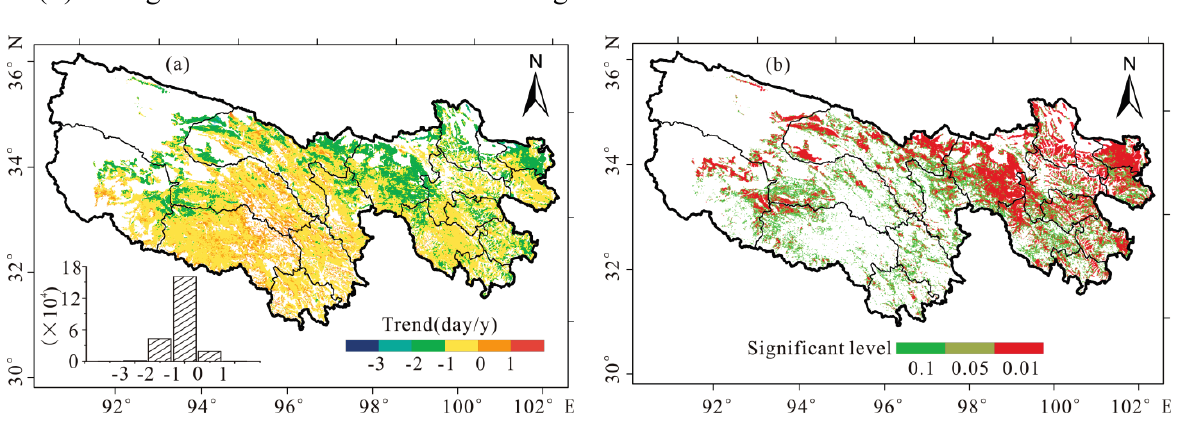
Figure 3. ( a ) The spatial pattern of the trend in the vegetation green-up date and ( b ) the significance level of the trend during 1999–2013 in the